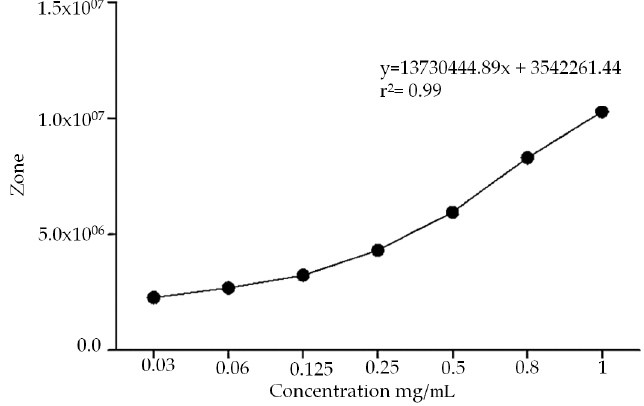
Figure 2. Calibration curve of phytopreparation from Asclepias subulata. Calotropin was quantified using different concentrations (0.3-1 mg/mL) whit standard addition method by